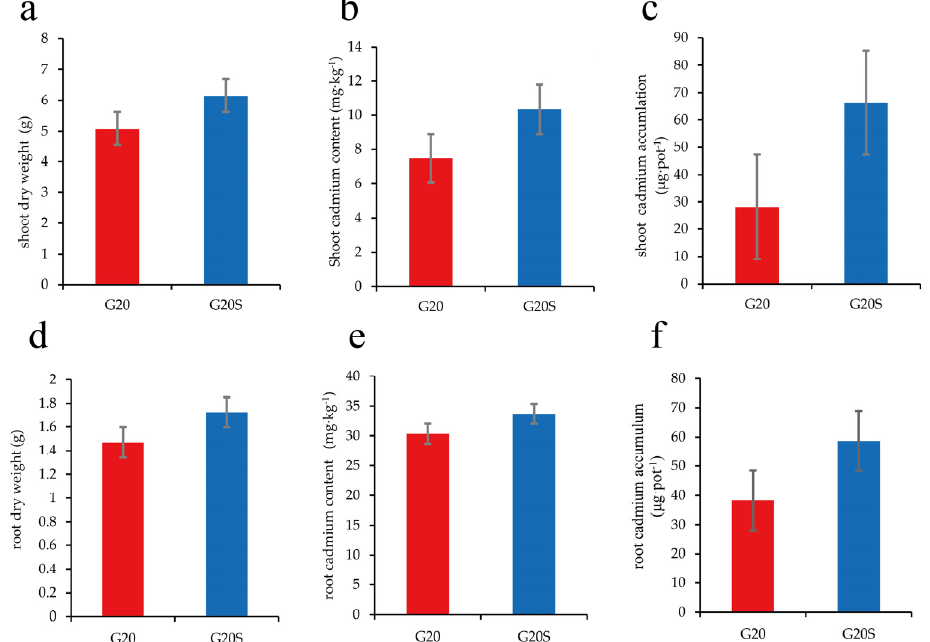
Figure 1. Sweet sorghum biomass and Cd accumulation under the G20 (noninoculation) and G20S (strain SR-9 inoculation) treatments: ( a ) shoot dry weight ( b ) shoot Cd content ( c ) shoot Cd accumulation ( d ) root dry weight ( e ) root Cd content, and ( f ) root Cd accumulation.